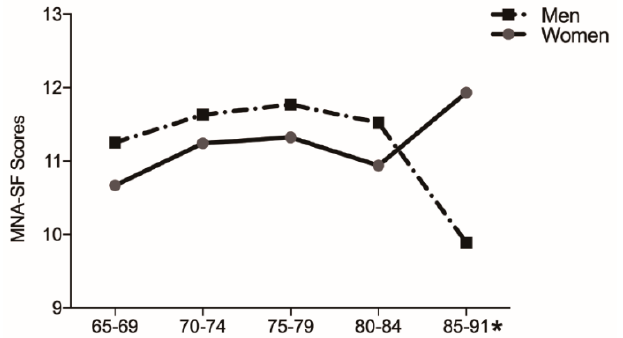
Figure 1. The Mini Nutritional Assessment Short Form (MNA-SF) scores for each sex and age group. *: MNA-SF scores showed significant differences for each sex in the 85–91-year age group.